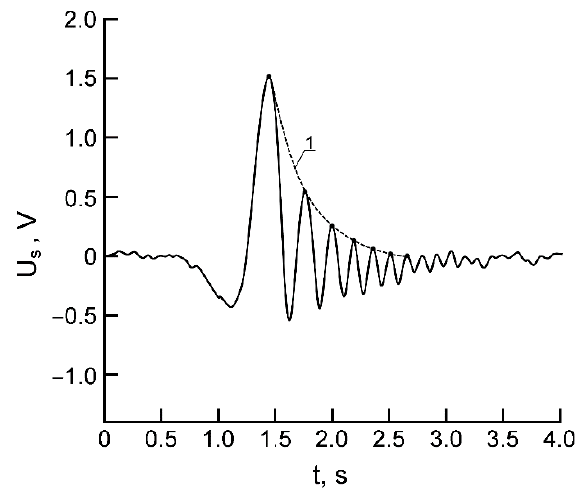
Figure 4. Dependence of the change in the amplitude U s of the registered NMR signal on time t . Graph 1 approximates the decay of the free induction signal during a single passage through the resonance.